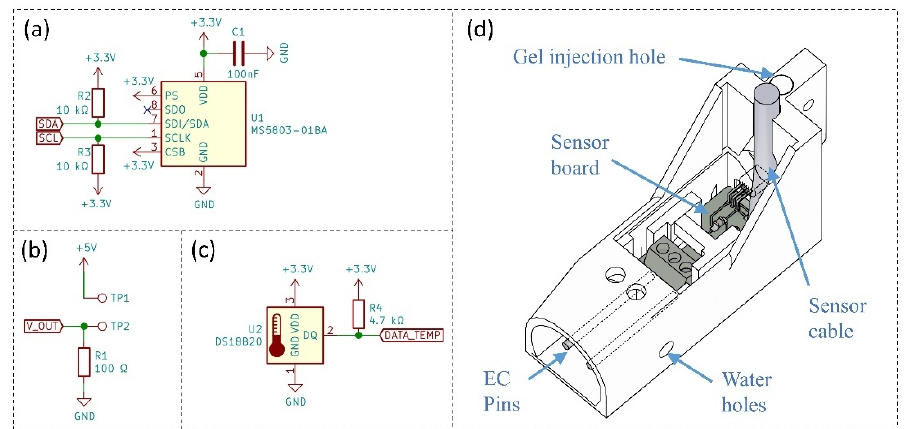
Figure 1. ( a ) The circuit design of MS5803-01BA sensor with I 2 C communication: +3.3 V for the power supply, GND for ground connection, and SDA and SCL for the I 2 C bus; ( b ) a simple voltage divider circuit to measure the conductivity of water-based on 5 V power supply: R1 is the selected 100 Ω resistor in this study, TP1 and TP2 are the two screw terminals on the PCB circuit to connect with the stainless steel rod, and V_OUT connects to one of the analog pins on the MCU to measure the voltage drop across R1; ( c ) the circuit diagram of a digital temperature sensor DS18B20: DATA_TEMP wire connects to one of the digital pins on the MCU to measure the environment temperature; and ( d ) sensor housing design with a vertical wall at the back of the sensor for easier